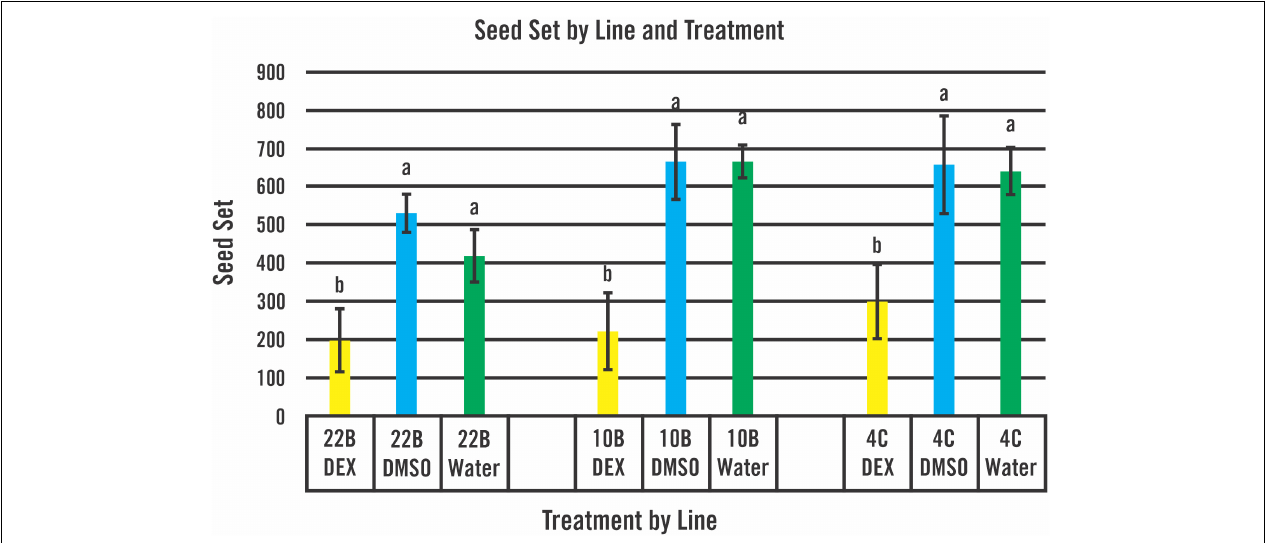
FIGURE 3 | Seed set of homozygous T 2 lines by treatment and line. A mature seed number was calculated for the first 10 flowering panicles. The number of plants treated for each line and treatment is found in Supplementary Table 1 . Plants in all three lines treated with 100 µ M DEX displayed significantly less mature seeds than plants treated with DMSO or no treatment controls. Error bars based on SD. Mean totals for seed set within a line not sharing a common letter were significantly different ( P < 0.01) as determined by ANOVA using the Holm-Sidak comparison